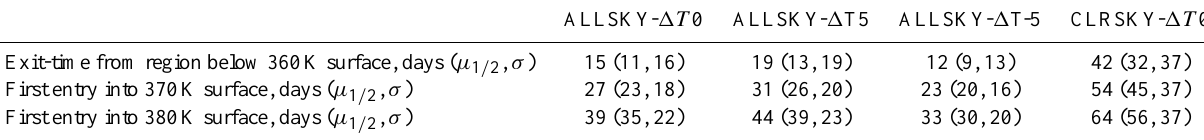
Fig. 9. Histograms showing (a) first-entry times of cloud air to the 370K surface (solid) and 380K surface (dotted) and (b) times for cloud air to cross the 360–370K layer (solid) and 360–380,K layer (dotted). Results obtained for all-sky and clear-sky conditions from four CS-TTL trajectory ensembles, all launched at 100hPa. The histograms are calculated using a bin size of 4 days. Table 4. Mean characteristics of the distributions of times for transport of cloud air out of the region below 360K and into the 370K and 380K surface for the first time. Calculations made using the four CS-TTL trajectory ensembles, all launched at 100hPa. The values for the median, µ 1 / 2 , and standard deviation, σ , are given in parenthesis. ALLSKY- 1T 0 ALLSKY- 1 T5 ALLSKY- 1 T-5 CLRSKY- 1T